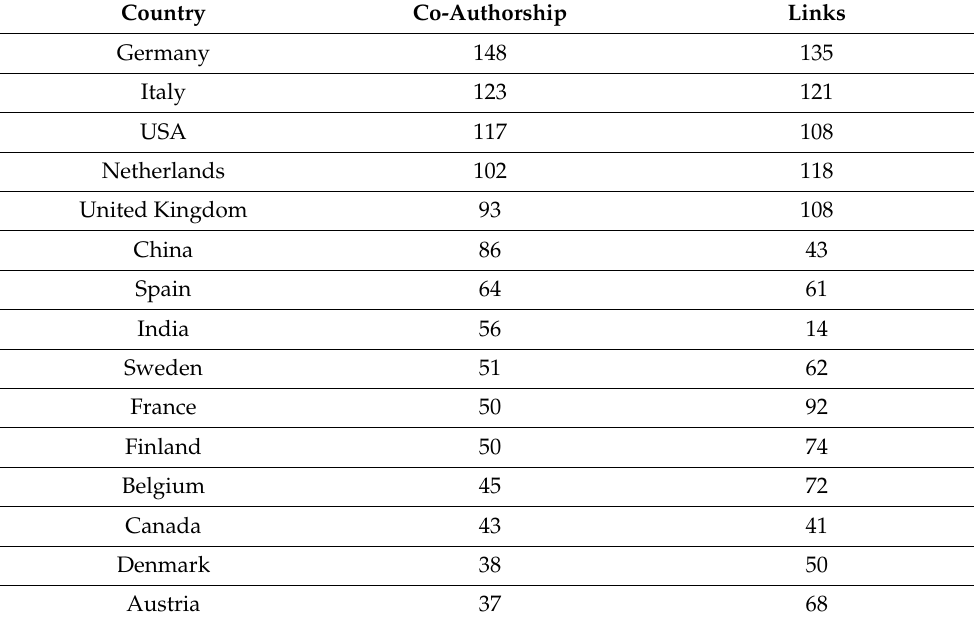
Table 3. The 15 countries with the most publications. Country Co-Authorship